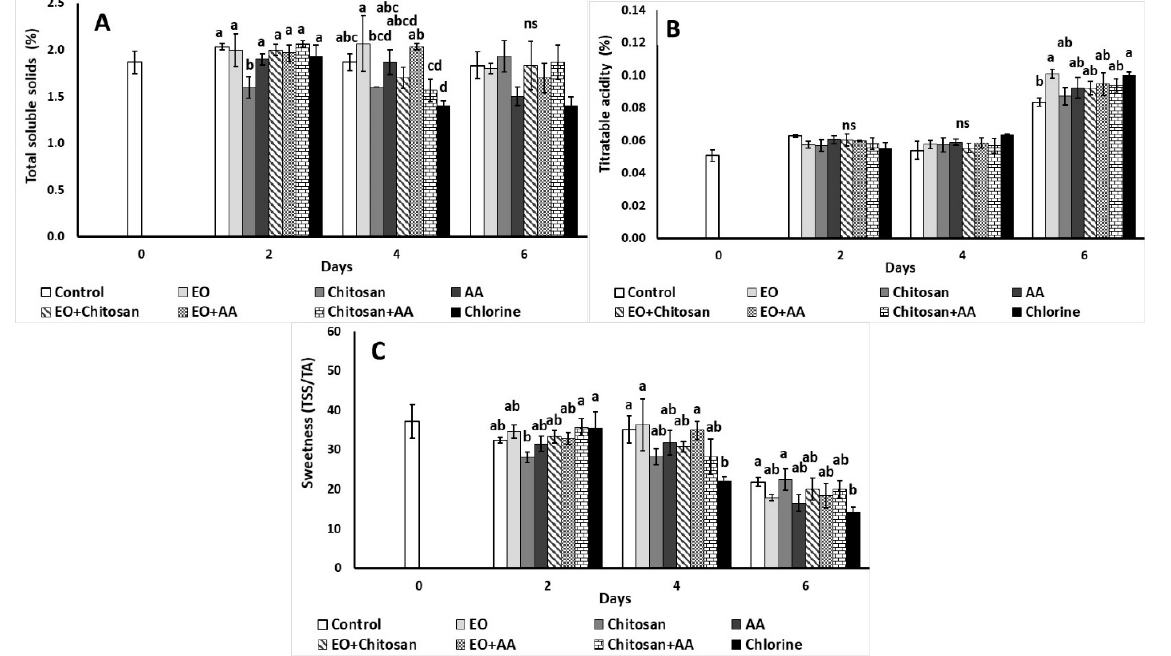
Figure 5. Effect of marjoram essential oil (EO), chitosan and ascorbic acid (AA) on fresh-cut lettuce ( A ) total soluble solids (TSS; %), ( B ) total acidity (TA; %), and ( C ) sweetness (TSA/TA) after treatment and 6 days storage at 7 °C and 90% RH. On the columns, significant differences ( p < 0.05) among treatments are indicated by different Latin letters; ns indicates no significant differences for different days. Values represent means (±SE) of measurements made on three biological replicates per treatment.